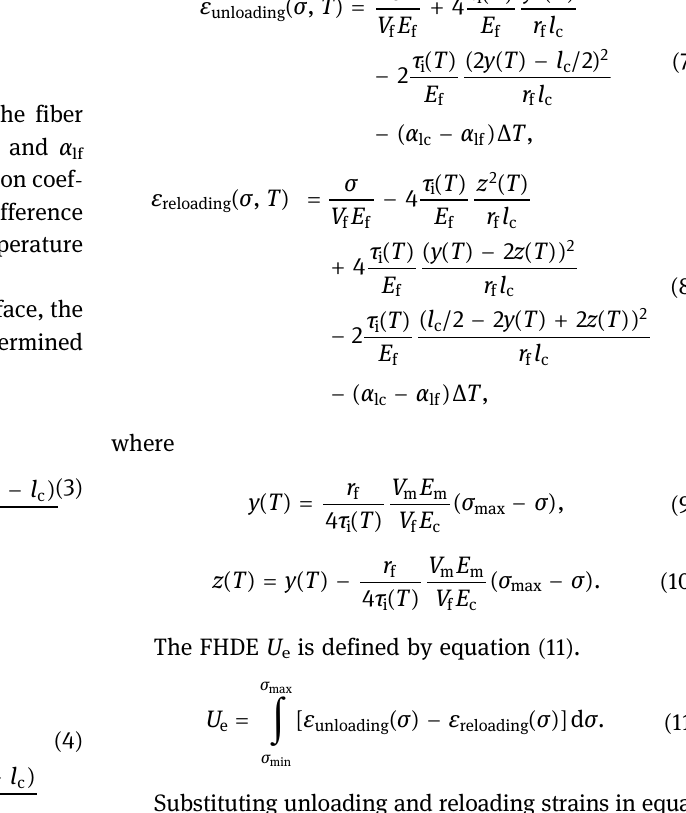
Figure 2: Schematic figure for fiber sliding relative to matrix upon ( a ) unloading and ( b )